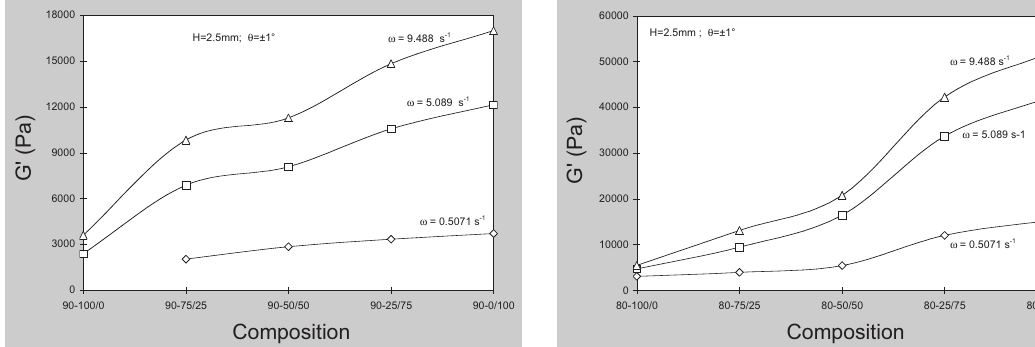
Figure 7 (left) : Storage modulus G’ as a function of angular frequency, w , for composition of LL - GF/KF composites at 10 vol% rein- forcement. Figure 8 (right): Storage modulus G’ as a function of angular frequency, w , for composition of LL - GF/KF composites at 20 vol% rein-